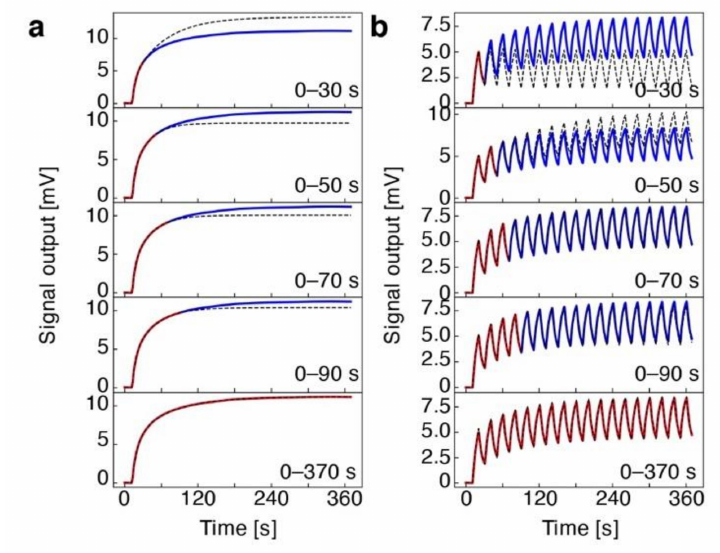
Figure 7. Fitting accuracy between a single injection signal response and multistep injection–purge cycles. ( a , b ) Comparison of experimentally measured signal responses of polycaprolactone-coated MSS exposed to 1,2-Dichlorobenzeneat the concentration of P a / P o = 30% and calculated signal responses based on a single injection signal response model ( a ) and a multistep injection–purge cycles model ( b ). Red colored signal responses are used for optimizing each fitting curve. Black dashed lines are the corresponding fitting curves. Reprinted from Ref. [96], the authors licensed under CC-BY 4.0.